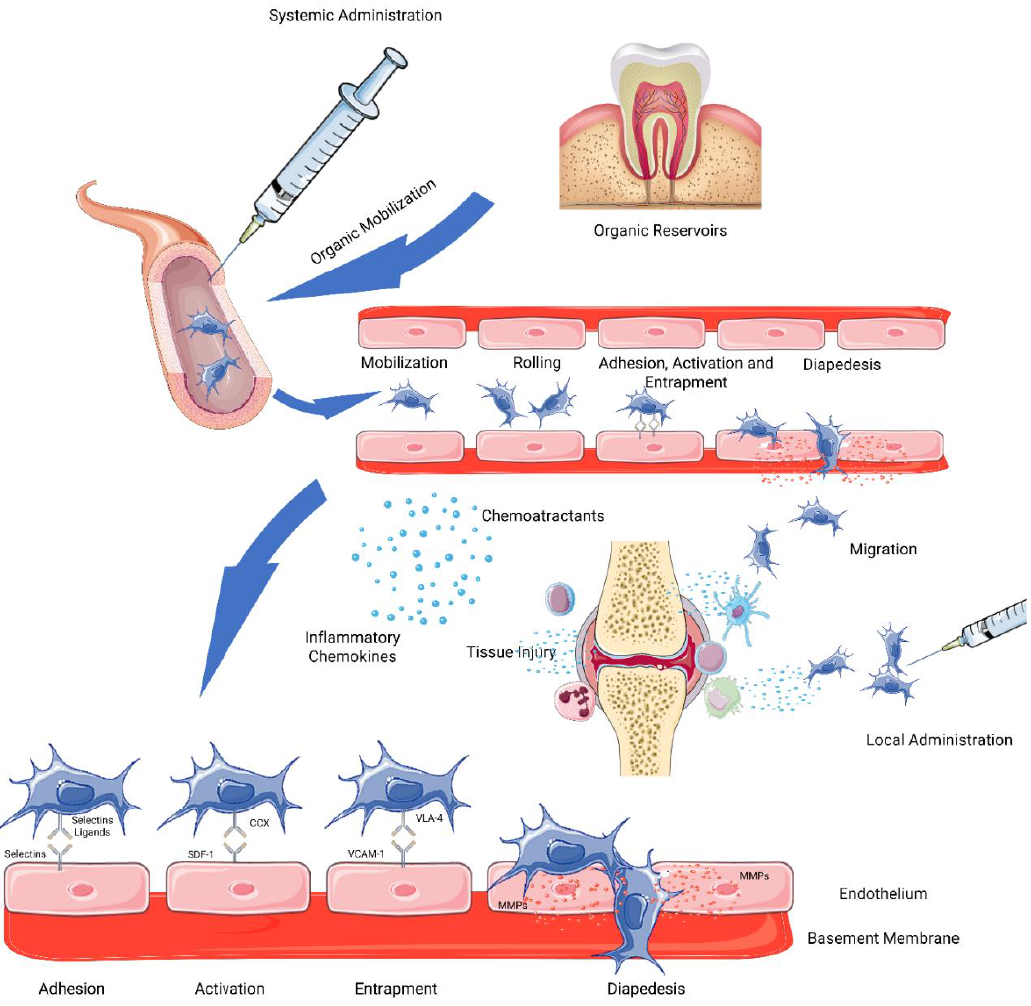
Figure 1. Schematic representation of the Migration and Homing processes, secondary to systemic administration, local administration, or organic mobilization of MSCs. (Adapted with permission from Servier Medical Art, licensed under a Creative Common Attribution 3.0 Generic Licence. https://smart.servier.com/. Accessed on January 5, 2022).